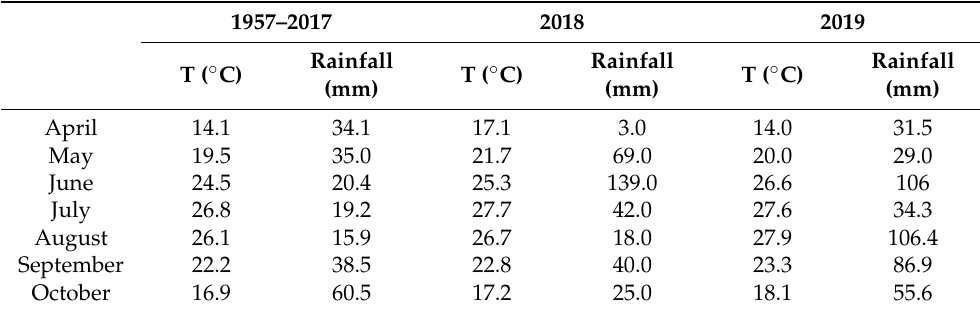
Table 1. Monthly average temperature (T; ◦ C) and rainfall (mm) recorded for the growing